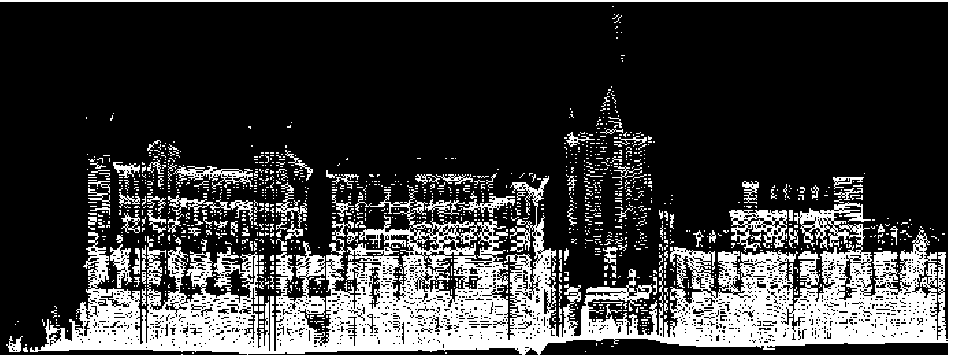
Figure 7. Binary image of point cloud projection Image.